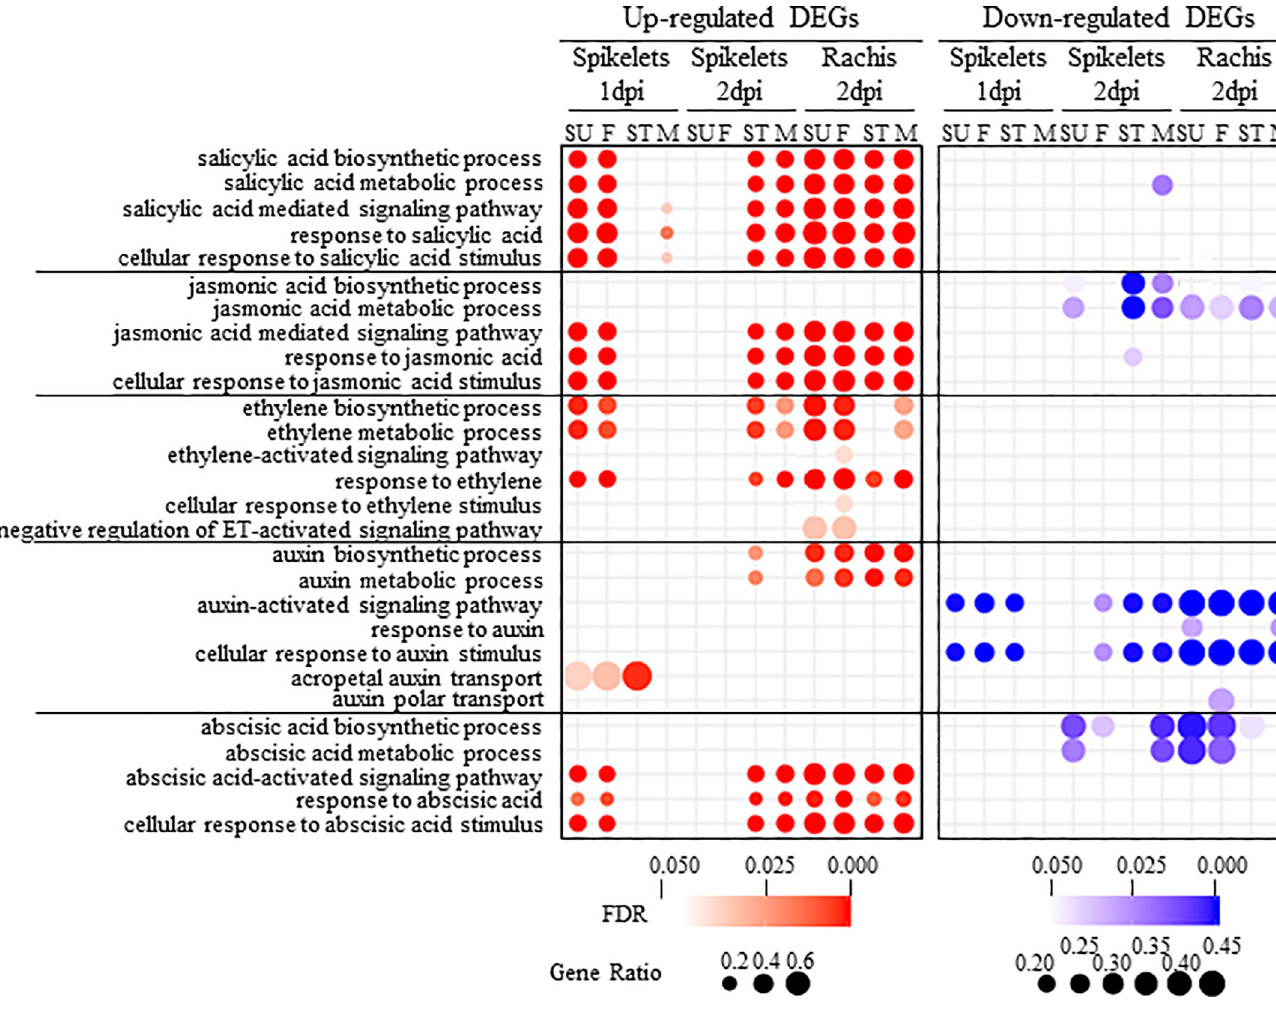
Fig 4. Gene Ontology (GO) enrichment analysis for phytohormone related pathways. Gene ratio equals the number of differentially expressed genes against the number of genes associated with a GO term in wheat genome. The Fisher test was performed to indicate the significance of GO enrichment (FDR < 0.05).